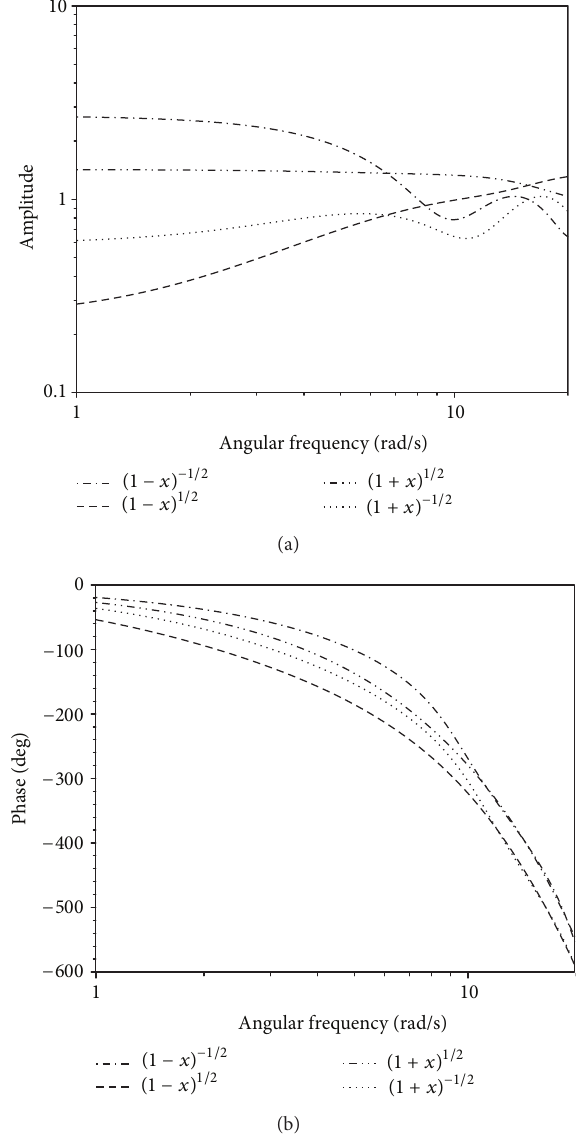
Figure 3: Frequency response, 𝐾 = 1, 𝑇 = 0.1 s, and the control algorithms (7)–(10) for 𝜔 ∈ [1, 20]